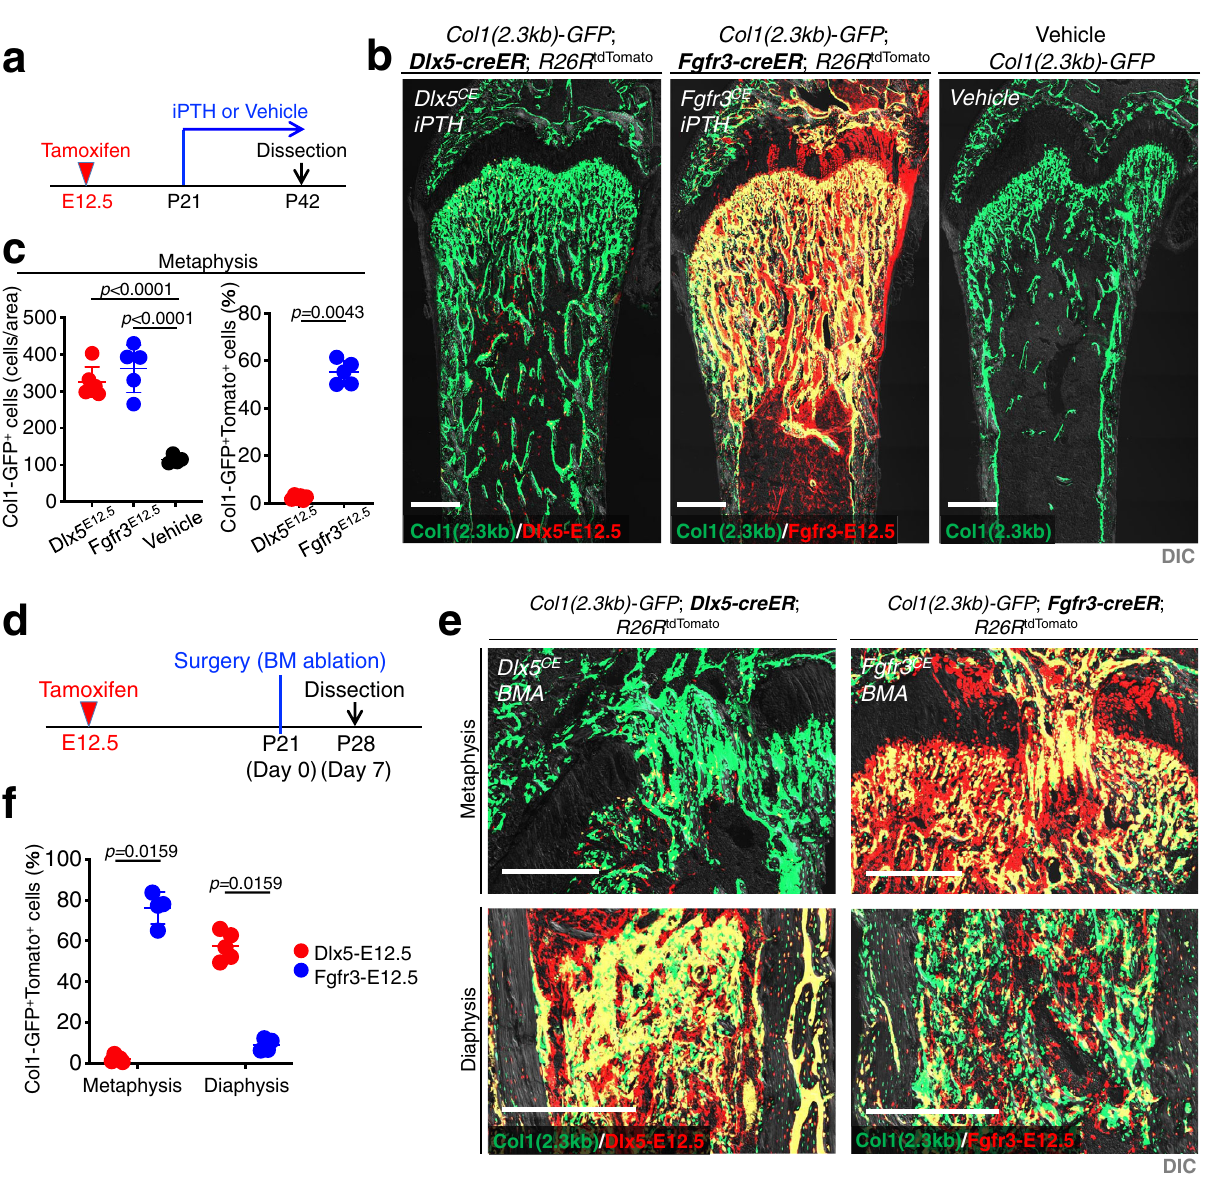
Fig.7| AnabolicandinjuryresponsesofDlx5-creER + perichondrialcell-derived marrow stromal cells. a – c Differential responses of marrow stromal cells derived from Dlx5 + perichondrial cells and Fgfr3 + chondrocytes to intermittent adminis- tration of parathyroid hormone (PTH) (iPTH). (b): Col1a1(2.3kb)-GFP ; Dlx5-creER ; R26R tdTomato (Dlx5 CE -E12.5, left), Col1a1(2.3kb)-GFP ; Fgfr3-creER ; R26R tdTomato (Fgfr3 CE - E12.5,center),and Col1a1(2.3kb)-GFP ; R26R tdTomato (Control,right)distalfemurs,with iPTHorVehiclefor3weeksfromP21toP42.Scalebar:500 µ m.(c):Quanti fi cationof Col1a1(2.3kb)-GFP + cells(left)and Col1a1(2.3kb)-GFP + tdTomato + cells(right)inthe metaphysis. n =6 (Dlx5 CE -E12.5), n =5 (Fgfr3 CE -E12.5), n =4 (Control) mice. Two- tailed, One-wayANOVAfollowed by Tukey ’ s post-hoc test (left).Two-tailed, Mann- Whitney ’ s U -test(right).Dataarepresentedasmean±s.d.Exact P valueisindicated in the fi gures. d – f Injury-responsive osteogenesis of marrow stromal cells